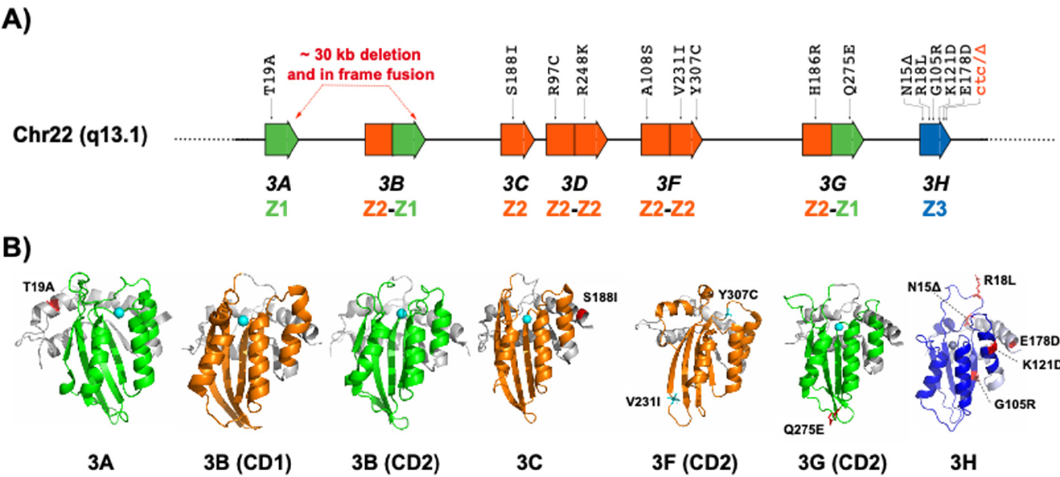
Figure 2. A schematic of main human APOBEC3 variantions shown on ( A ) human chr22 and ( B ) the available human APOBEC3 structures. The catalytic domains Z1, Z2, and Z3 are colored in green, orange, and blue,